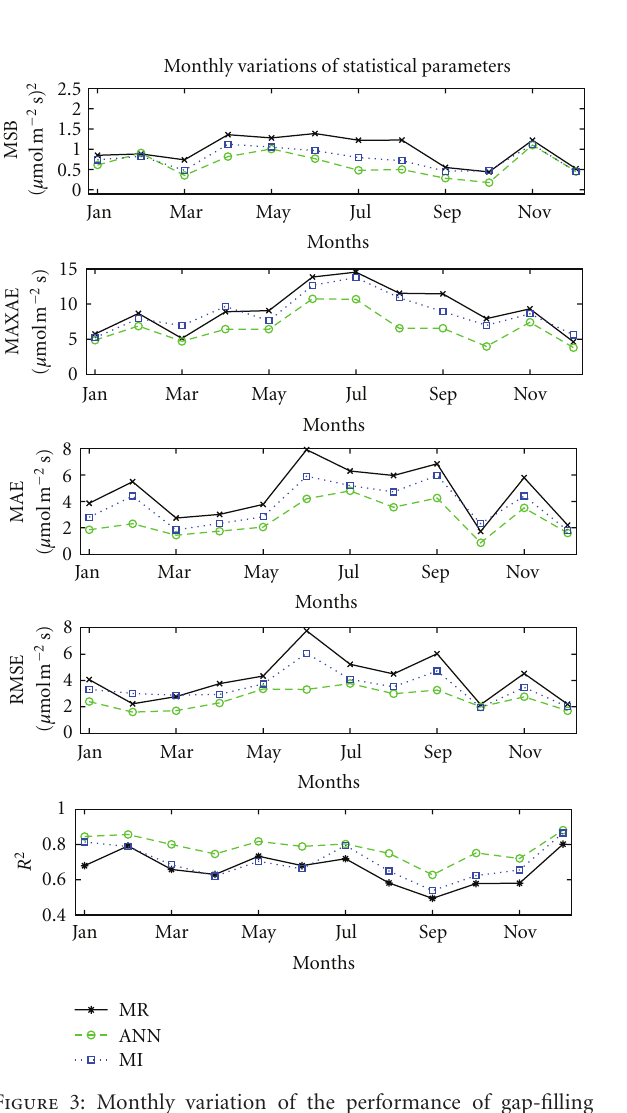
Figure 3: Monthly variation of the performance of gap-filling techniques MR (black line, stars), ANN (green line, circles) and MI (blue line, squares) measured by statistical parameters.